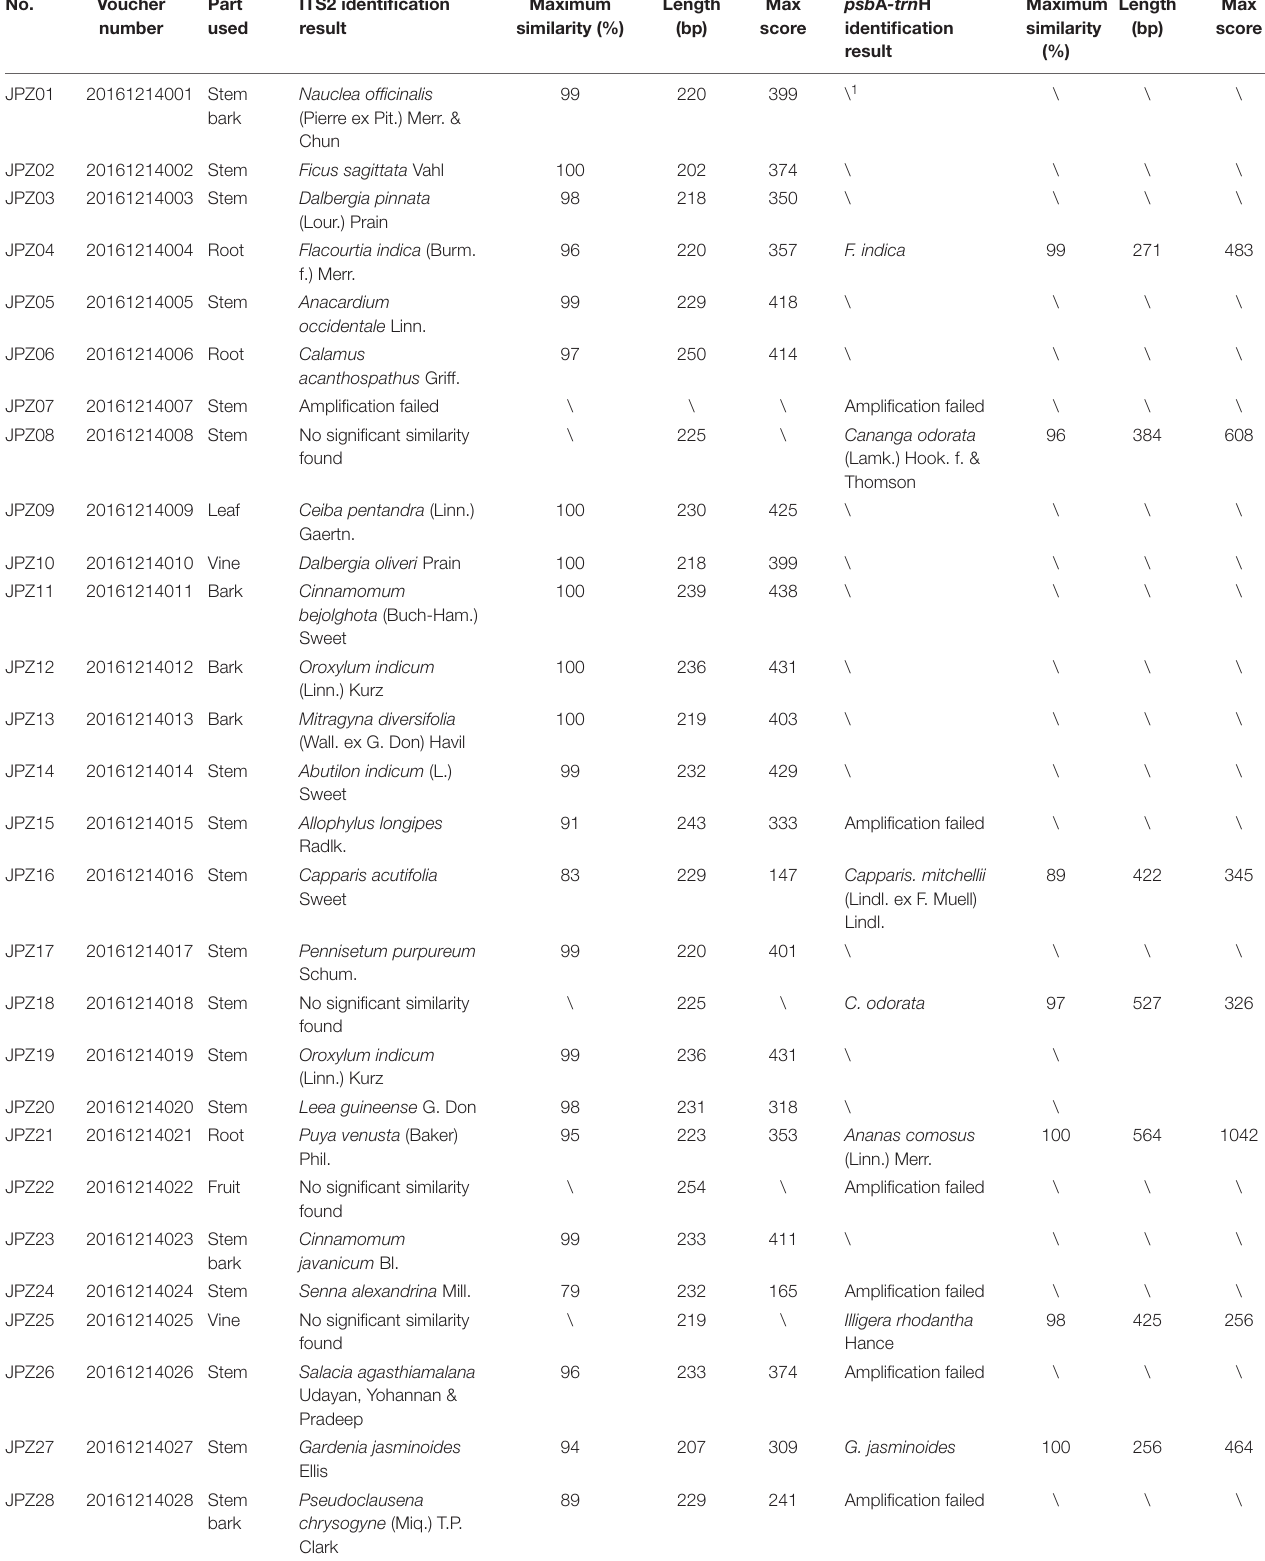
TABLE 1 | Herb identification results of ITS2 supplemented with psb A -trn